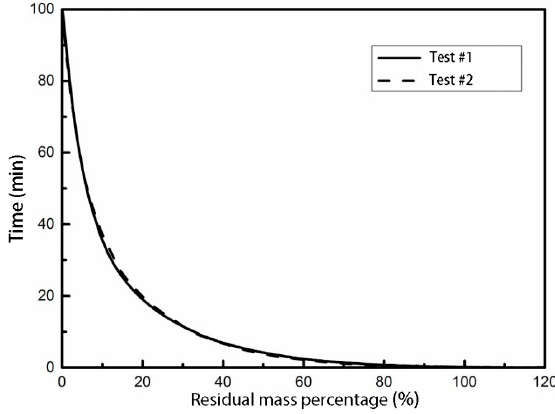
Figure 7. Repeatability test of pure ethylene flame soot nascent particles.